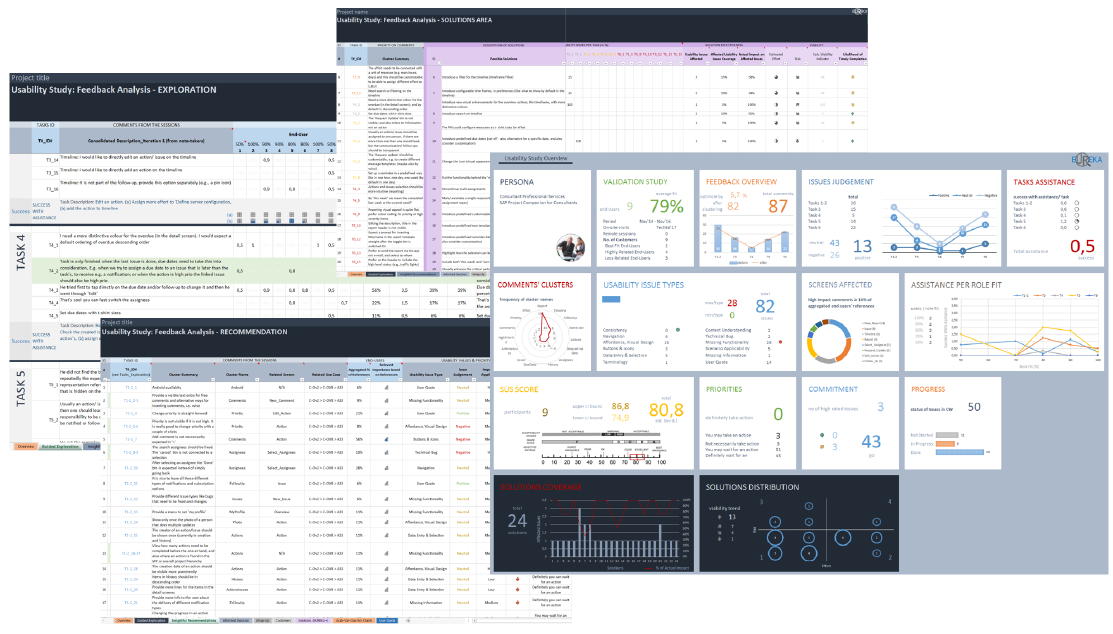
Figure 8. Snapshots of the EUREKATAX functional prototype